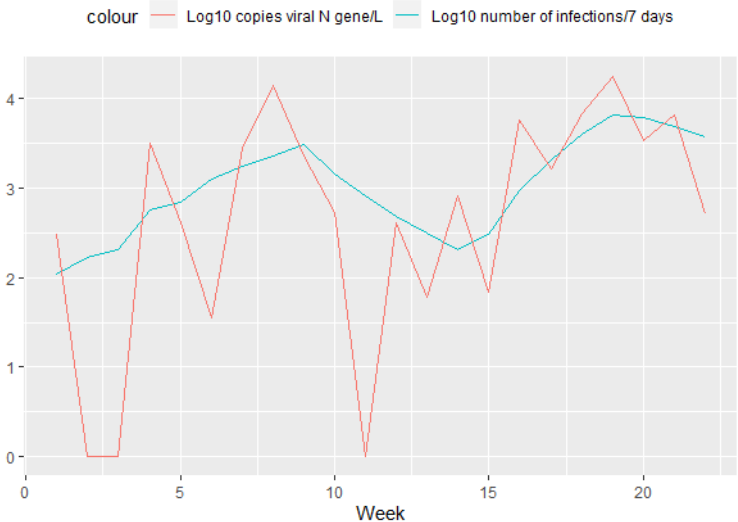
Figure 4. Log10 transformed amount of viral nucleic acid (N gene) detected in WWTP influent (red line) and the log10 transformed total number of infections that occurred during the week before sampling (blue line).